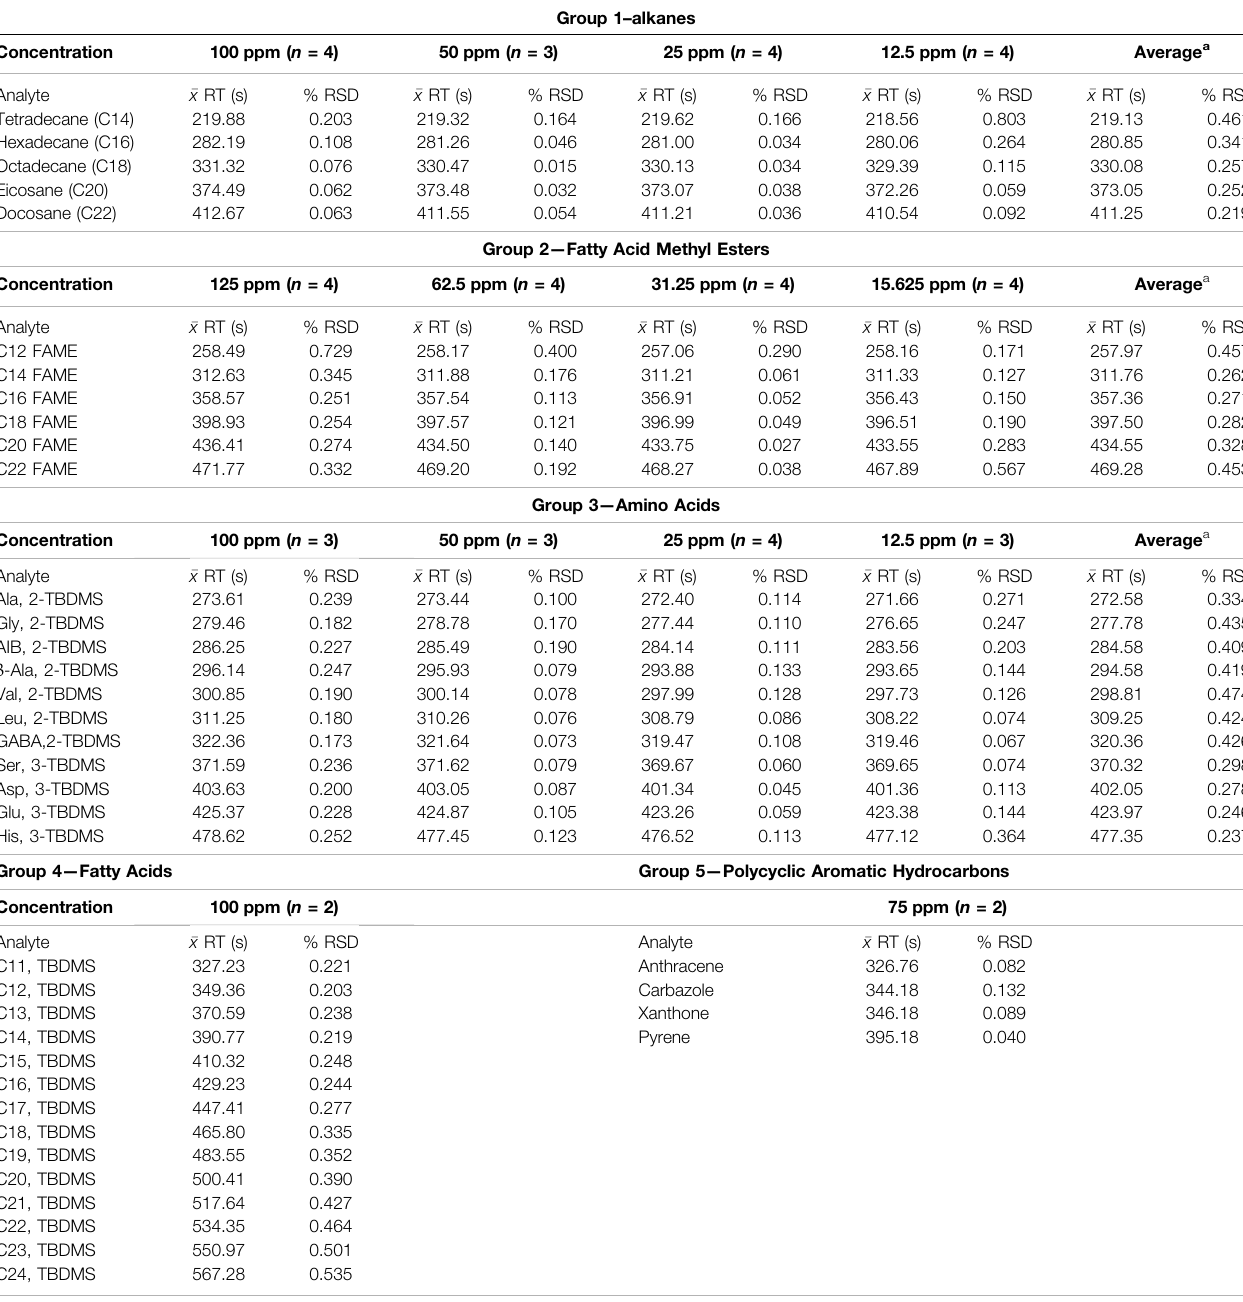
TABLE 4 | Average retention time and percent relative standard deviation (% RSD) for multiple injections of the fi ve different chemical families (groups) at different